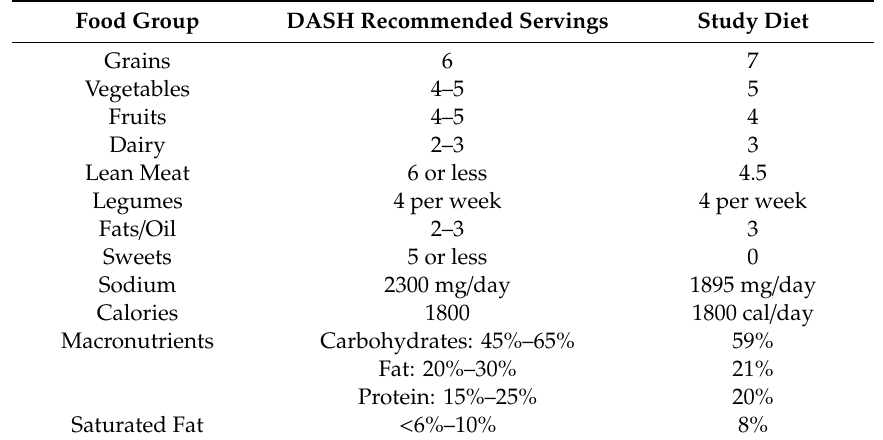
Study diet compared to Dietary Approaches to Stop Hypertension (DASH) recommended